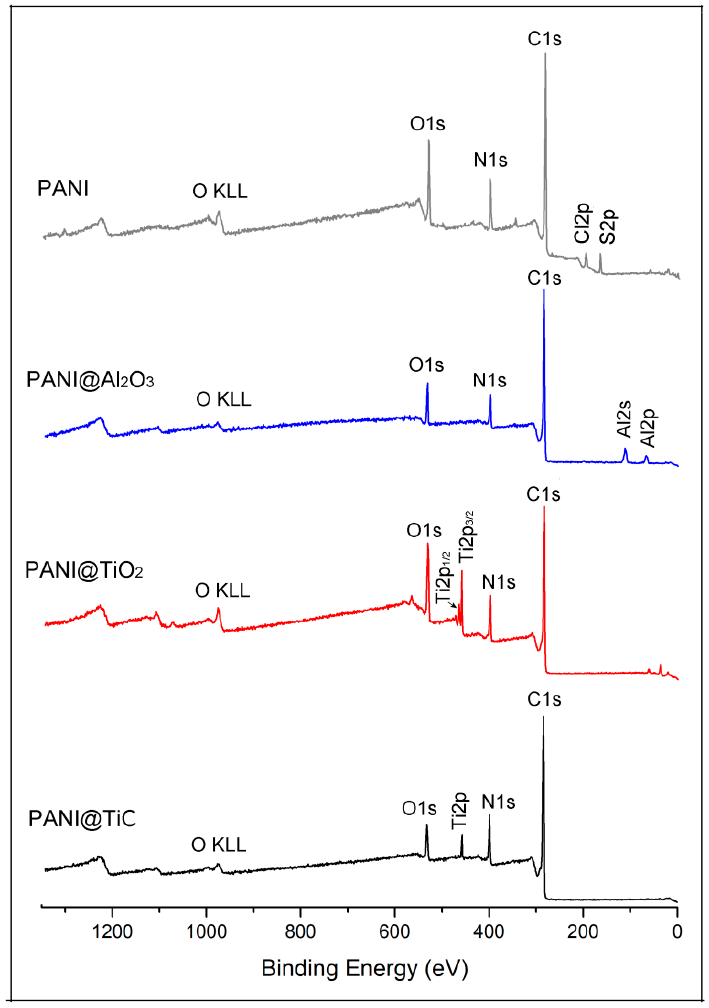
Figure 1. X-ray photoelectron spectroscopy (XPS) survey scan spectrum of synthesized materials. To further investigate the change in the electronic structure of the hybrid materials, Gaussian deconvolution peak integration was used to calculate the respective proportions of the N 1 s peak (Figure 2). In this way, the N 1 s spectrum of the PANI@TiO 2 sample can be subdivided into three peaks, for which the assignment of the binding energies is listed in Table 1. The first peak at 398.39 eV corresponded to neutral amines, the second peak at 399.53 eV corresponded to imine species, and the last peak at 400.33 eV could be assigned to the nitrogen cationic radical (–N + ), which is also present in the structure of PANI [30]. Similarly, for the PANI@TiC sample, the three peaks appearing at 398.51 eV, 399.71 eV, and 400.83 eV corresponded to quinoid amine (–N=) and benzenoid amine (–NH– and –N + ). In contrast, the spectrum of PANI@Al 2 O 3 showed only two peaks at 398.22 eV and 399.48 eV, which could be assigned to − N= and − NH − , respectively. On the other hand, the ratio of the areas under [=N–]/[–NH–] compositions indicates the quantitative intrinsic oxidation state (OS) of the samples [23]. The area ratio of the lowest binding energy to the total area band is an indicator of the doping degree (DD) [30]. The quantitative data on the intrinsic oxidation state and doping level of the hybrid